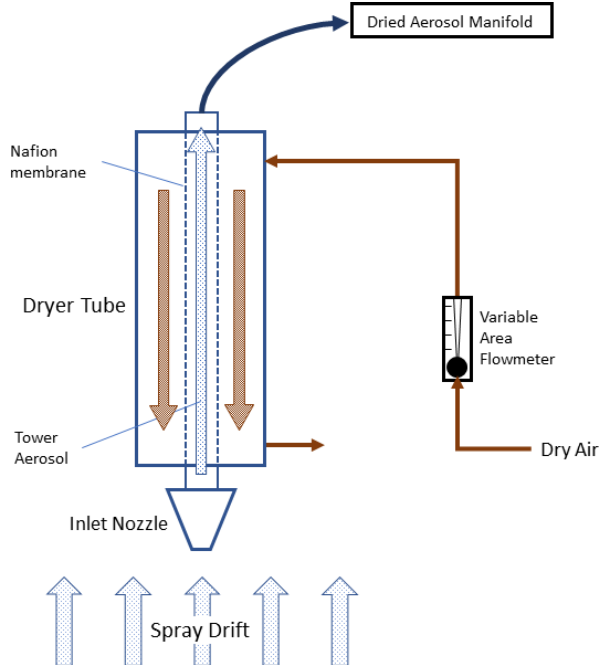
Figure 4. Configuration for a single MD-700